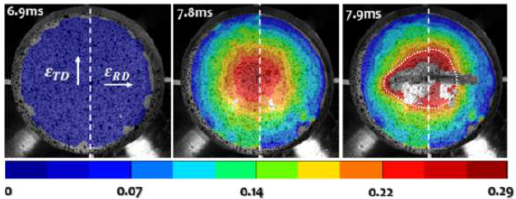
Fig. 4. Full-field contour plots of strain in the rolling and transverse directions, i.e., RD and TD resp., at different instants of the experiment at 16.5 m/s